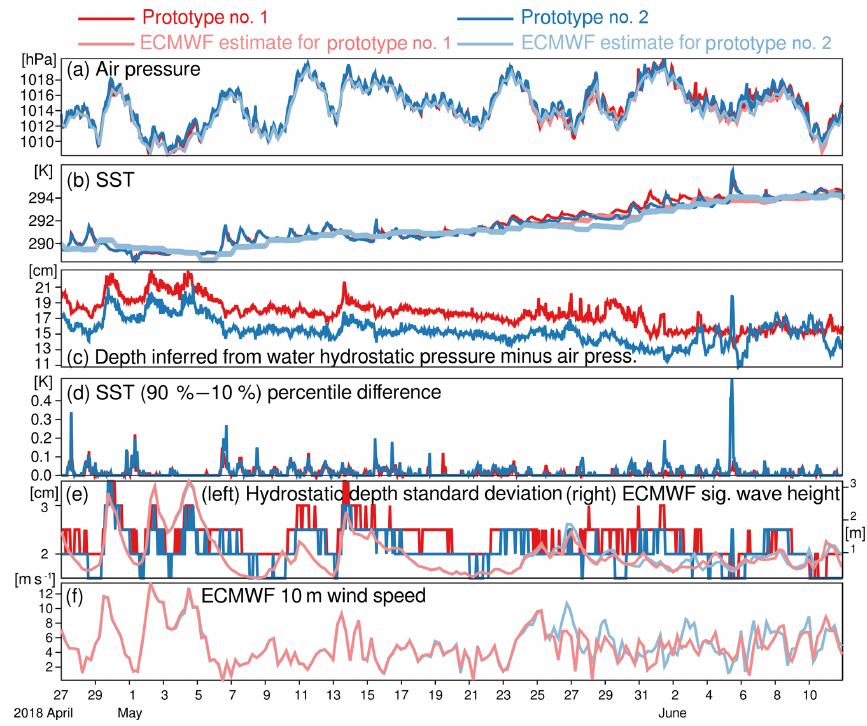
Figure 8. Time series of data collected by the two SVP-BRST prototypes until one of them ran ashore. Panels (a) , (b) , (e) , and (f) also show, in lighter colors, ECMWF analyses co-located to the buoys dates, times, and locations.